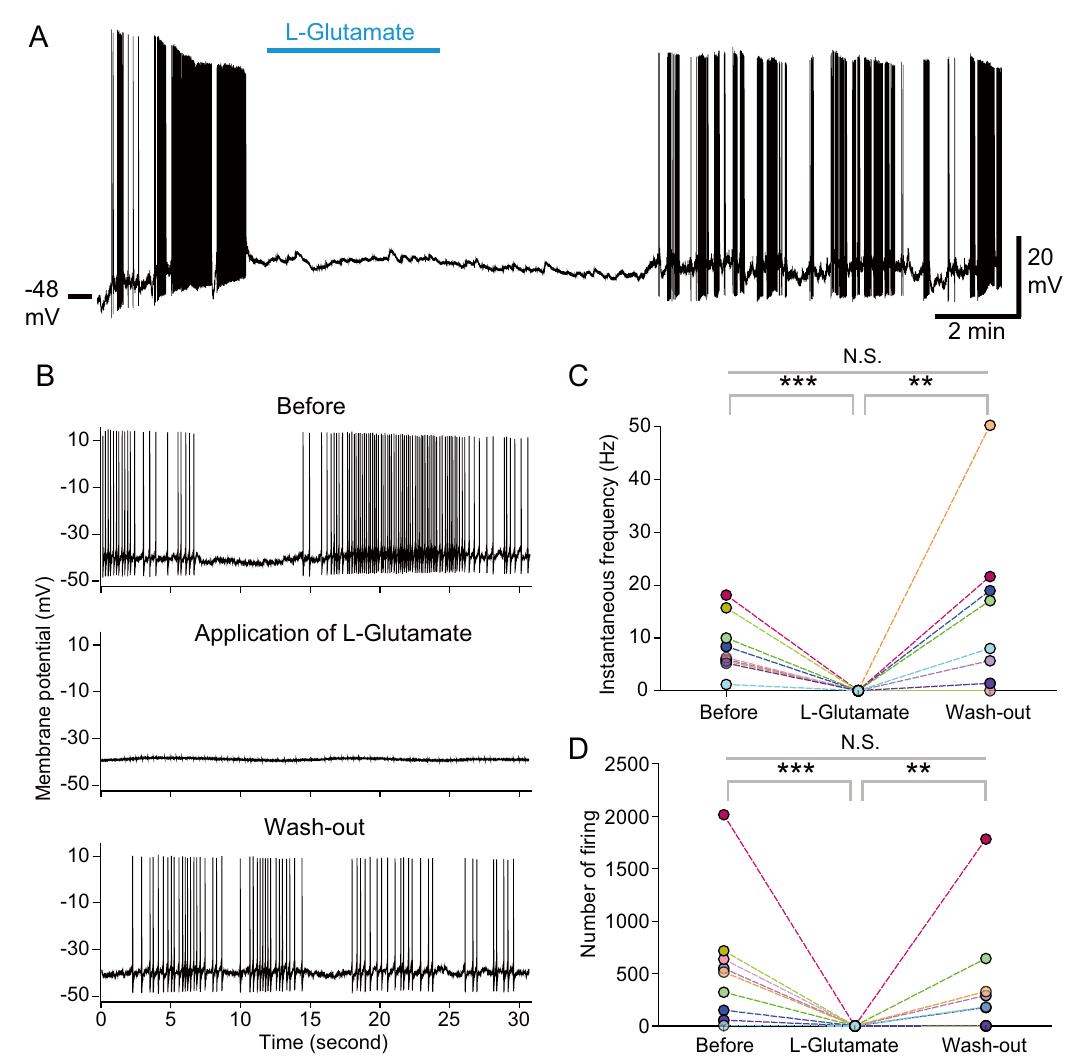
Fig 4. Perfusion of L-Glutamate acutely and strongly inhibits the spontaneous firing activity of PI neurons. (A) A representative trace showing effects of 1 mM of L-Glutamate perfusion on the spontaneous firing activity of PI neurons. (B) Traces showing the spontaneous activity of a PI neuron before the perfusion of glutamate (upper), during application of glutamate (middle), and after wash-out (lower). (C, D) Line graphs showing the (C) instantaneous frequency and (D) number of firing events in 3 min of “Before,” “L-Glutamate,” and “Wash-out” within each PI cell ( n = 9). We performed repeated Friedman test with post hoc Steel–Dwass test. Repeated Friedman test shows statistically significant differences in the instantaneous frequency and number of firing events ( P < 0.01). Symbols show statistical P values by Steel–Dwass test ( �� : P < 0.01, ��� : P < 0.001, N.S.: not significant). The underlying data can be found in the S1 Data datasheet of numerical values for each fig.xlsx. PI, pars